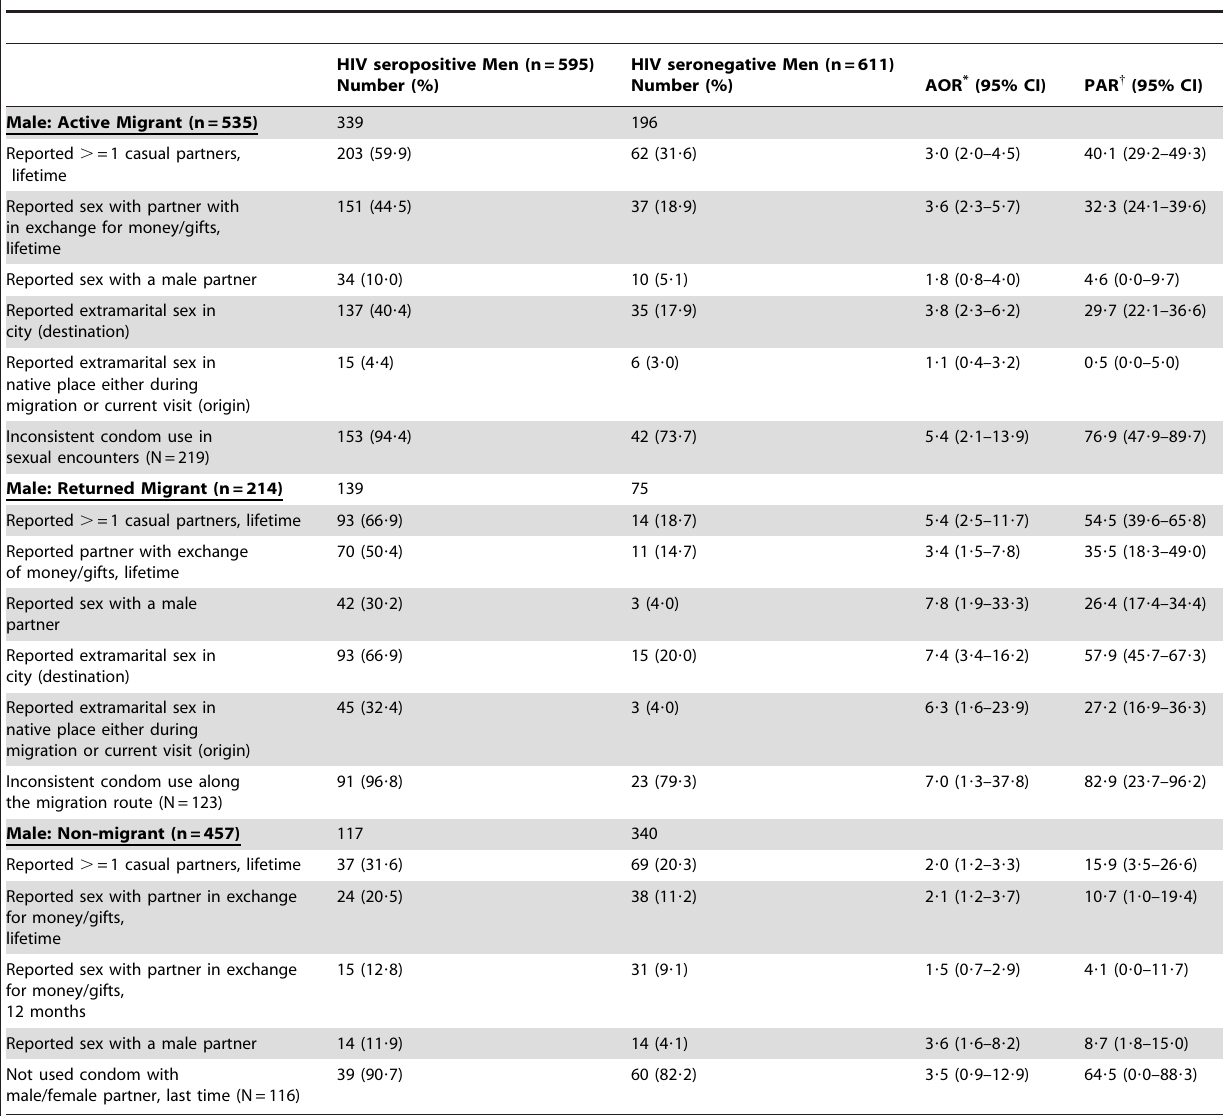
Table 3. Sexual/behavioral characteristics of HIV seropositive and HIV seronegative men by male out-migration status—East and North India, 2010.